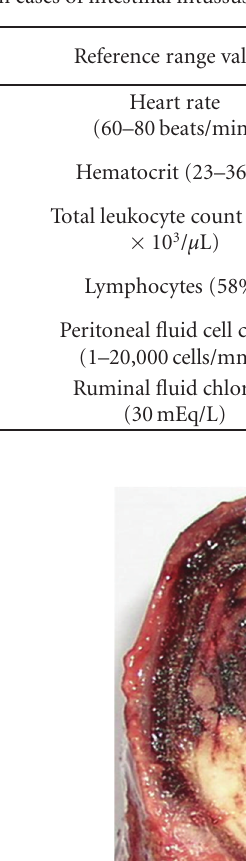
Table 1: Preoperative clinical parameters in cases of intestinal intussusception in cows.